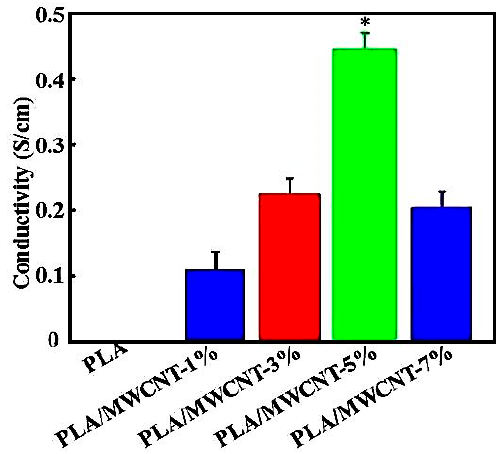
Figure 3. Conductivity of the PLA containing different amounts of MWCNTs.